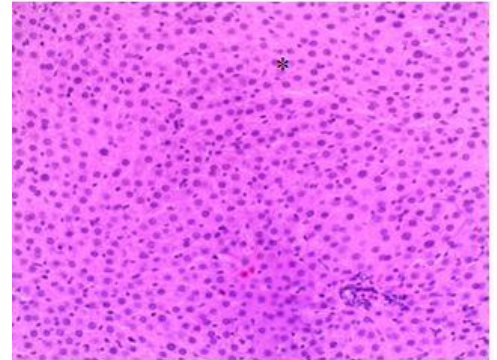
Fig. 1: The microscopical appearance of normal rat liver showing a typical structure of the liver (black asterisk). H&E, 400